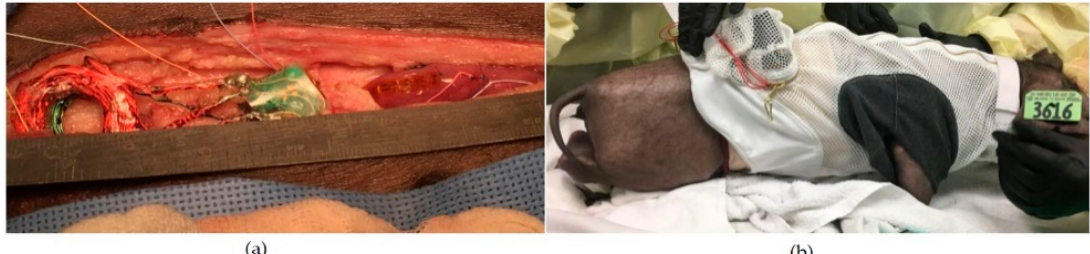
Figure 8. Experiment setup of chronic test. ( a ) EGMD was placed inside a pouch created in the abdominal wall with its electrode sutured on top of the intestine. Note that this deployment of each component of the EGMD helps mitigate signal loss of power and data signals due to tissue absorption, as separation between external and internal coils is merely abdominal-wall thickness, while the electrode array can be extended to access the intestine. Same deployment method is also applicable to future human studies to mitigate the issue of signal loss due to tissue absorption. ( b ) RD was carried by the pig.